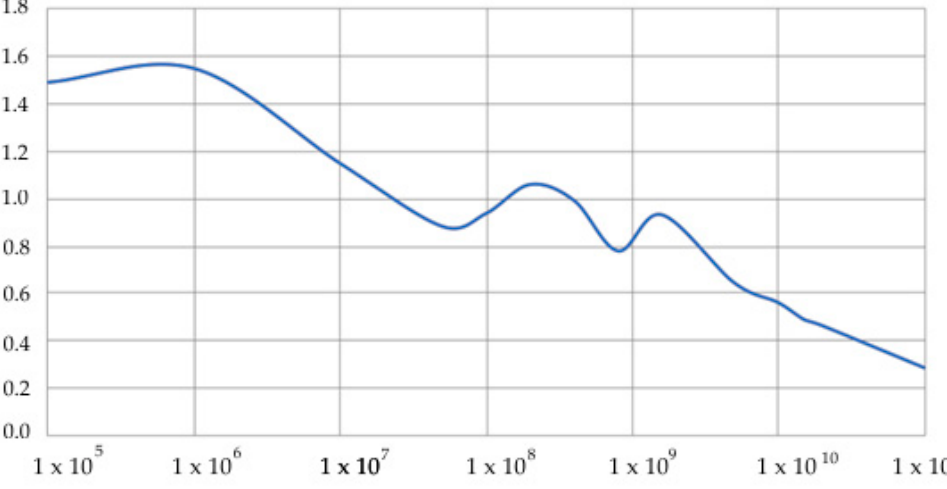
Figure 6. Dependence C ( E i , ρ i , h i ) on the modulus of elasticity of the immersion layer E 3 , Pa.